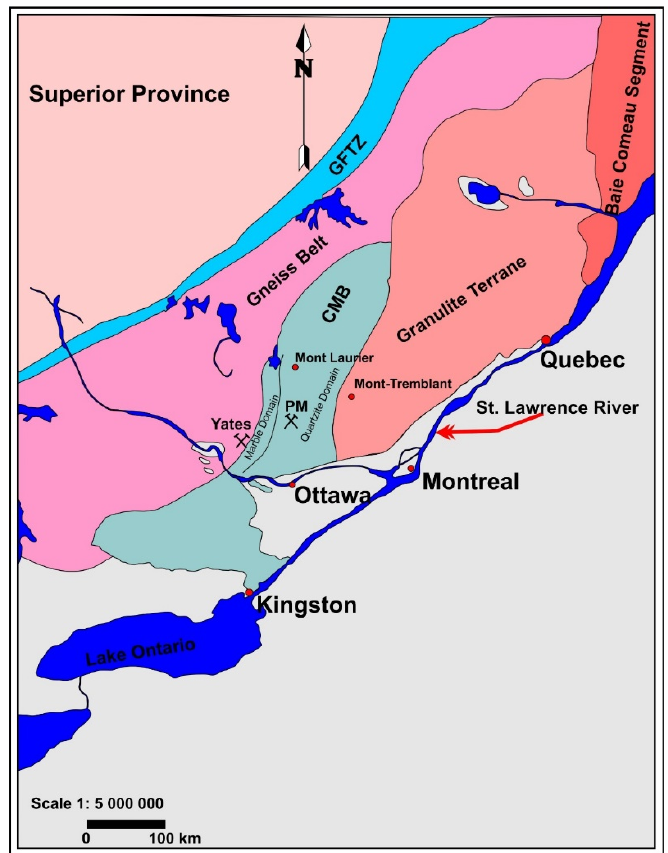
Figure 1. The geological setting and location of the Parker Mine with reference to Ottawa (Ontario), Montreal, the Yates prospect near Otter Lake, and Mont Tremblant (Quebec). After Wynne-Edwards [6]; GFTZ: Grenville Front Tectonic Zone, CMB: Central Metasedimentary Belt, PM: Parker Mine.